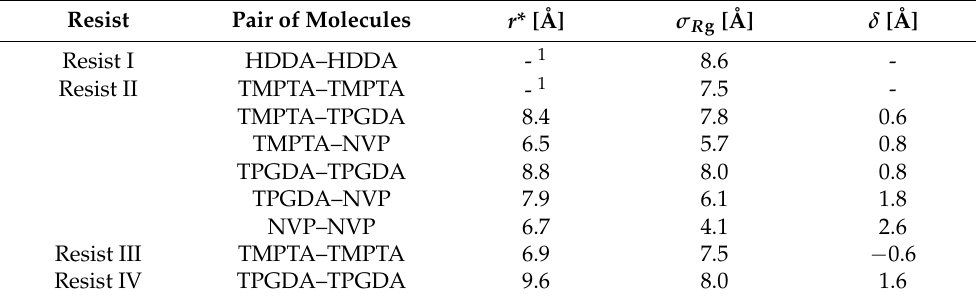
Table 5. Positions of the first peak of the radial distribution functions ( r *), the sum of radii of gyration ( σ R g ), and their differences, δ = r * − σ R g , for various molecule pairs in the bulk states. Resist Pair of